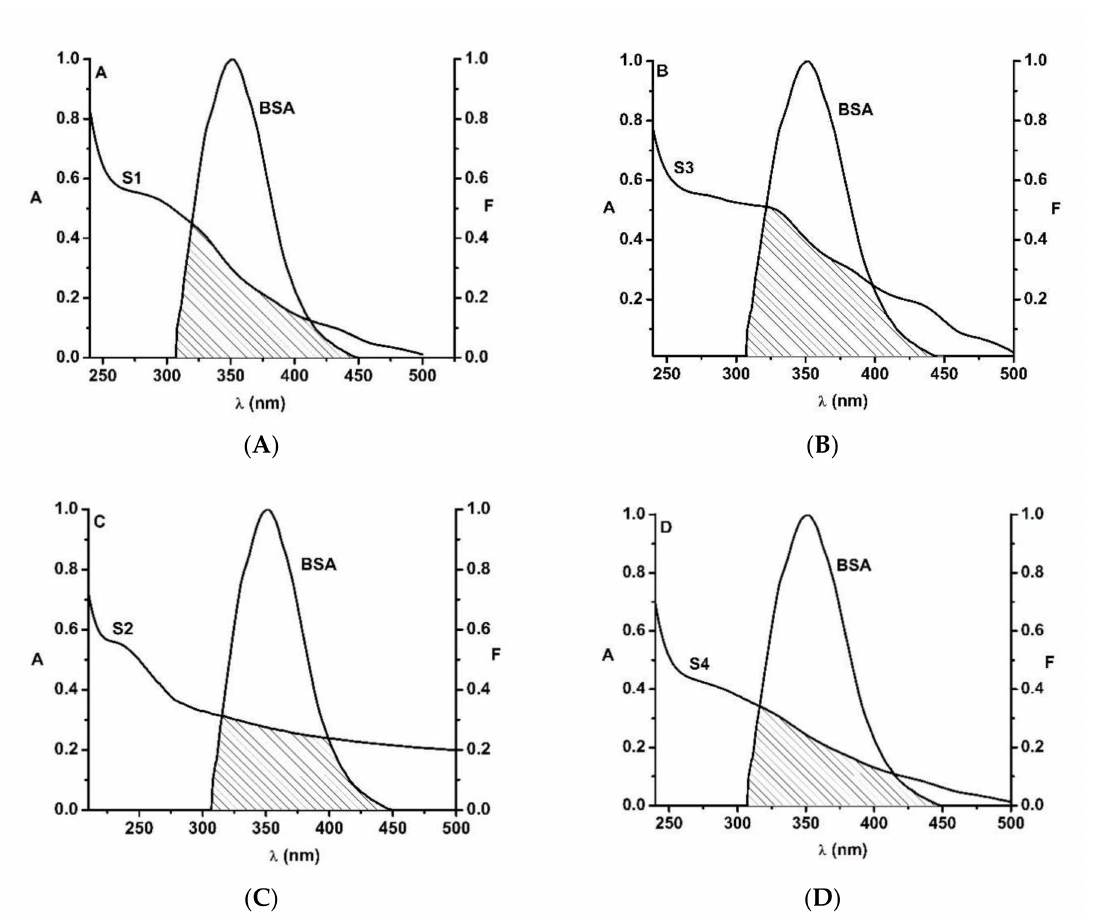
Figure 6. The overlap of the fluorescence emission spectrum of BSA and the absorption spectrum of biogenic ferrihydrite nanoparticles ([BSA]:[ferrihydrite nanoparticles] = 1:1) for the samples S1 ( A ), S2 ( B ), S3 ( C ) and S4 ( D ). Table 5. FRET parameters of the interaction of the biogenic ferrihydrite nanoparticles and BSA. Type of